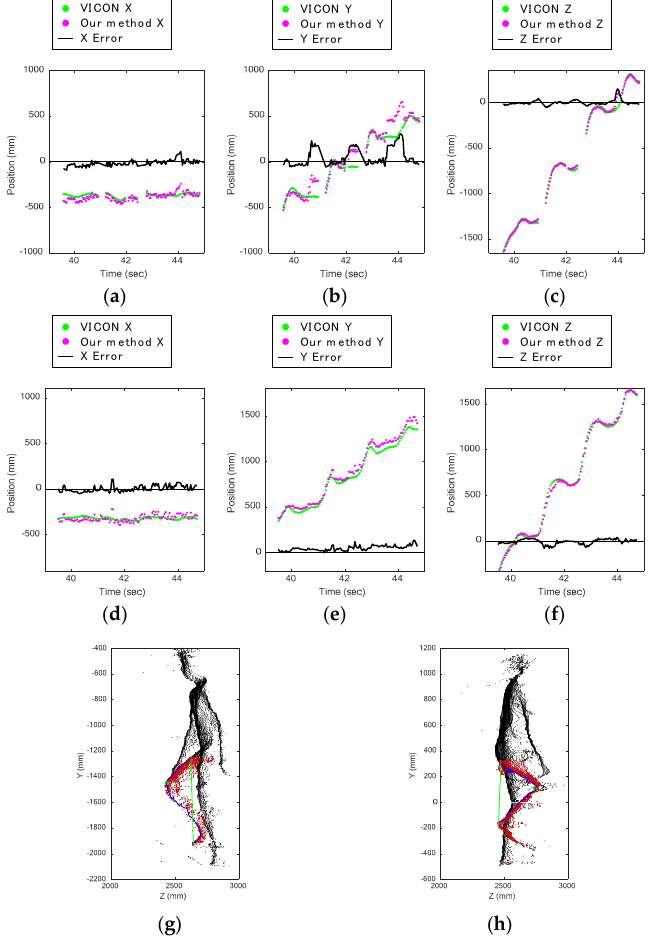
Figure 11. Comparison of results during ascent captured from the front and the back: ( a ) knee displacement on X axis during stair ascent captured by upper Kinect; ( b ) knee displacement on Y axis during stair ascent captured by upper Kinect; ( c ) knee displacement on Z axis during stair ascent captured by upper Kinect; ( d ) knee displacement on X axis during stair ascent captured by lower Kinect; ( e ) knee displacement on Y axis during stair ascent captured by lower Kinect; ( f ) knee displacement on Z axis during stair ascent captured by lower Kinect; ( g ) estimated knee joint position (green dot) and leg area (red dots) during ascent captured by upper Kinect; ( h ) estimated knee joint position (green dot) and leg area (red dots) during ascent captured by lower Kinect.